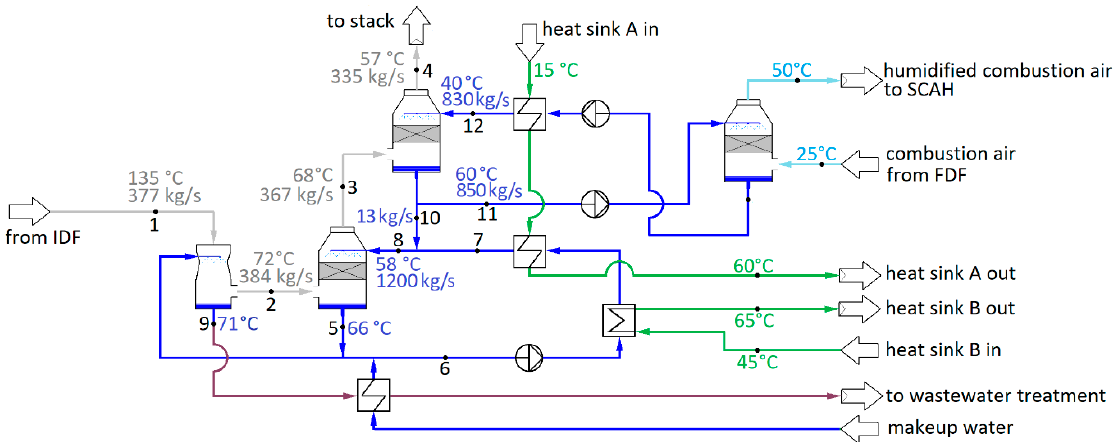
Figure 4. Heat recovery scheme with gas (1) entering an emission control scrubber (ECS). The cooled flue gas (2) enters the packed bed heat recovery scrubber (HRS) and exits to the stack at reduced moisture and temperature (4). Liquid water (5) from the HRS is used for ECS spray, and heat consumers (6). Water from the ECS (9) is sent to wastewater treatment. The water (8) entering the lower HRS consists mainly of the spray water (7) and the overflow from the upper HRS (10). The upper HRS flow (11) is pumped to 2-bar pressure for the combustion air humidifier (CAH) spray, and again for the upper HRS spray (12).